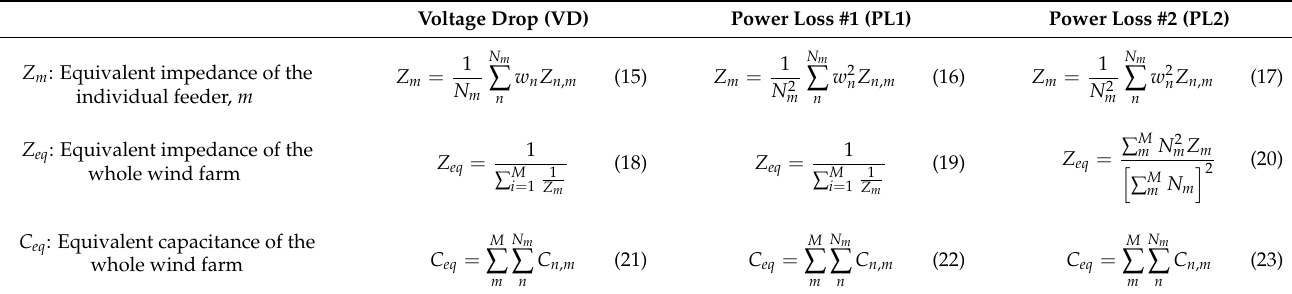
Table 3. Current based aggregation